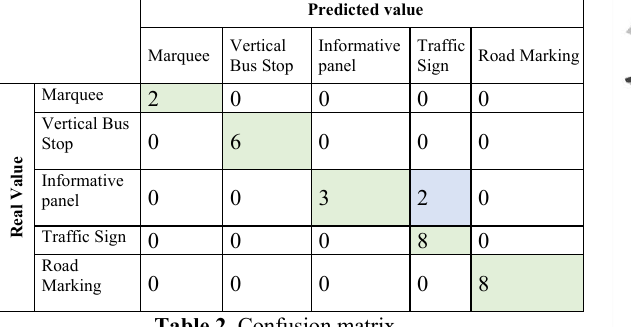
Table 2. Confusion matrix